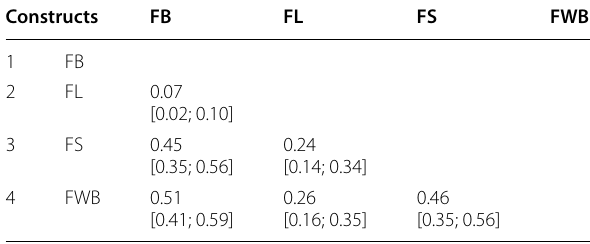
Values in the parentheses are the 95% bias-corrected and accelerated confidence interval